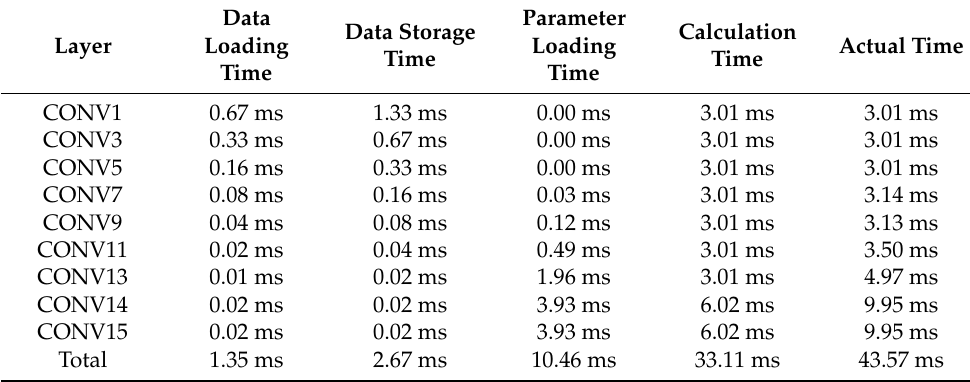
Table 5. Calculation time for convolutional layers.